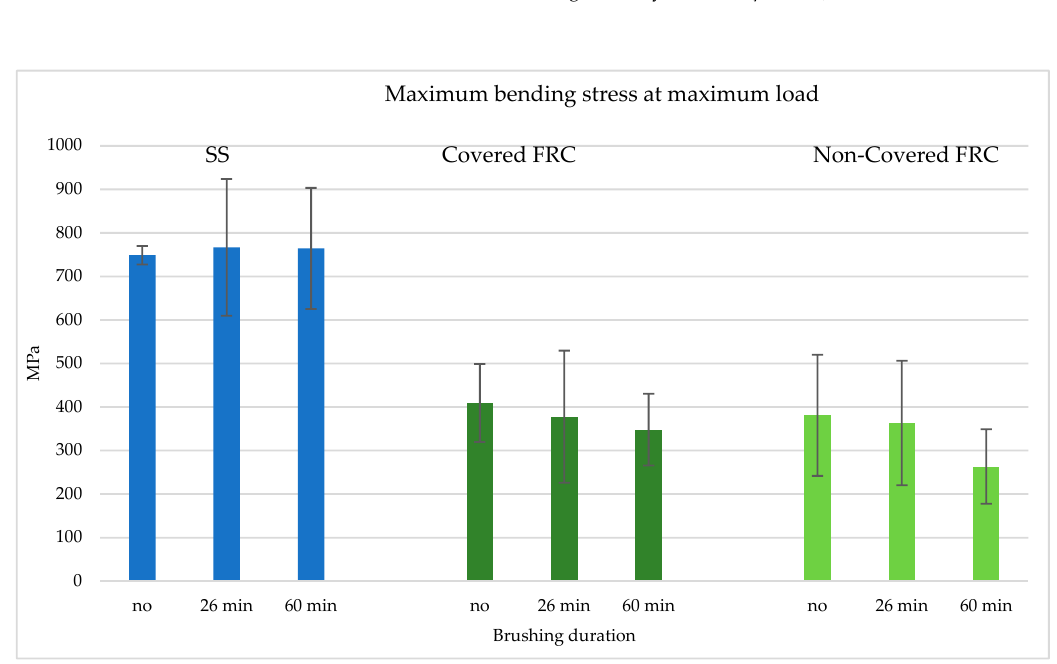
Figure 4. Graphical representation of maximum bending stress (Mean and SD) of the various conditions (metal, covered FRC, and non-covered FRC) after different brushing times (no brushing, 26 min of brushing, and 60 min of brushing).